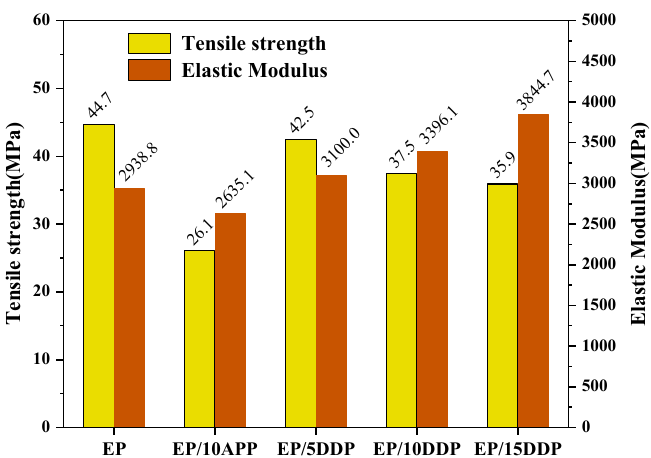
Figure 14. Tensile strength and elastic modulus of EP blends.